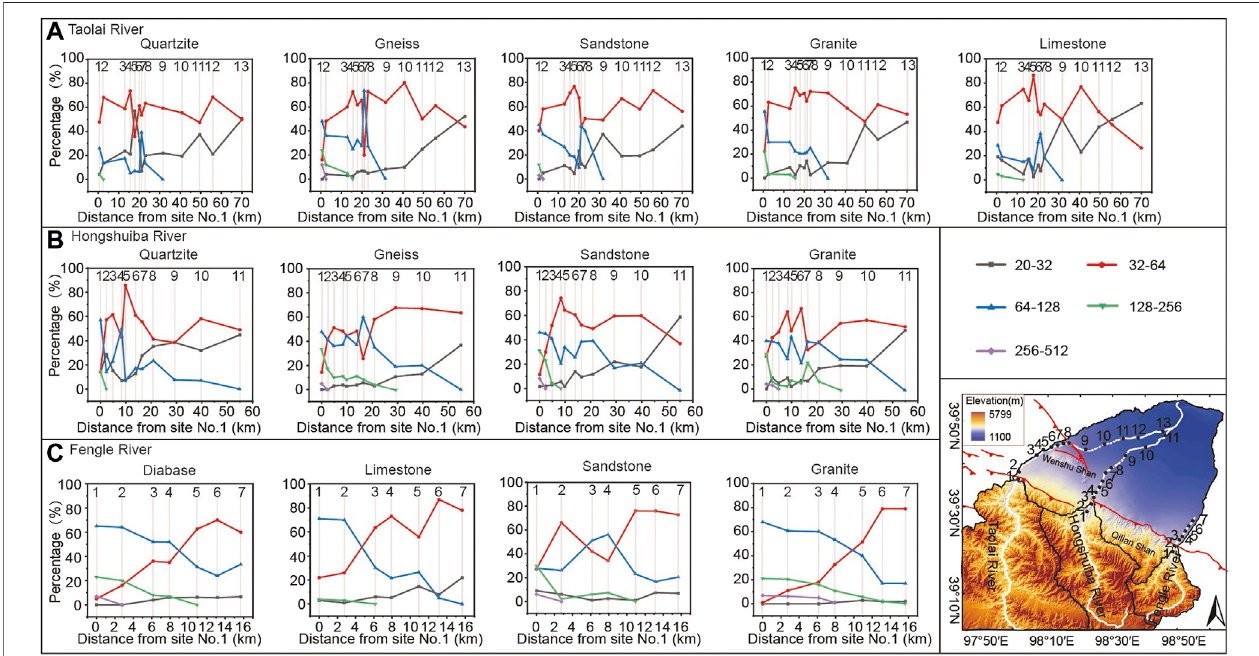
FIGURE 8 | Variation in the percentages of grain-size groups with different lithologies along the Taolai, Hongshuiba, and Fengle Rivers. The bedload gravels collected from every sampling site were classi fi ed according to their lithologies. For each lithology, the variation in the percentages of grain-size groups along the three rivers was then analyzed. (A) , (B) , and (C) Downstream variations in the percentages of grain-size groups with different lithologies, along the Taolai, Hongshuiba, and FengleRivers,respectively.Thereducedpercentagesofgrain-sizegroups > 128 mmtowarddownstreamarenotseeninthesmallergrain-sizegroups.Incontrast, for the groups < 128 mm, the reverse